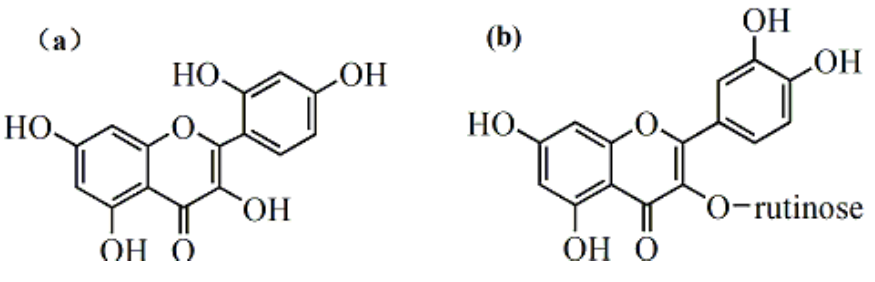
Figure 9. DPV of 5.0 × 10 −6 mol/L quercetin in a mixture of morin of the same concentration.